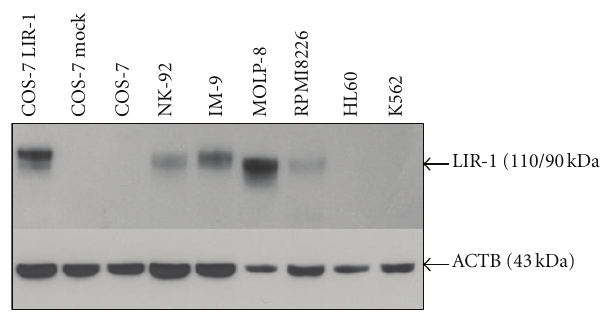
Figure 2: LIR-1 expression on NK-92 and target cells. Western blot analysis of LIR-1 expression on NK-92 cells and tumor cell lines. Untreated as well as LIR-1 or mock transfected COS-7 cells negative and positive controls, respectively. After film development, the membrane was stripped and reincubated with ACTB antibodies as a loading control. 4 μ g anti-LIR-1 and 10 μ g anti-ACTB (1:1000) were used for antigen detection. Lanes contended 35 μ g of total protein. As also shown by flow cytometric analysis, NK-92 as well as IM-9 and MOLP-8 expresses high levels of LIR-1, whereas no detection of LIR-1 was possible on HL60 and K562